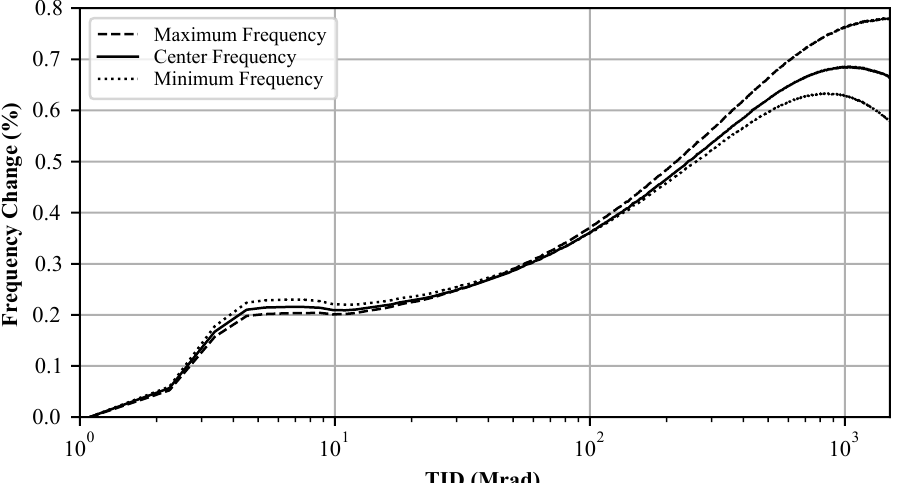
Figure 12. Evolution of DCO frequency under X-ray irradiation. A consistent frequency increase relative to the pre-irradiation value is seen for different frequency settings of the